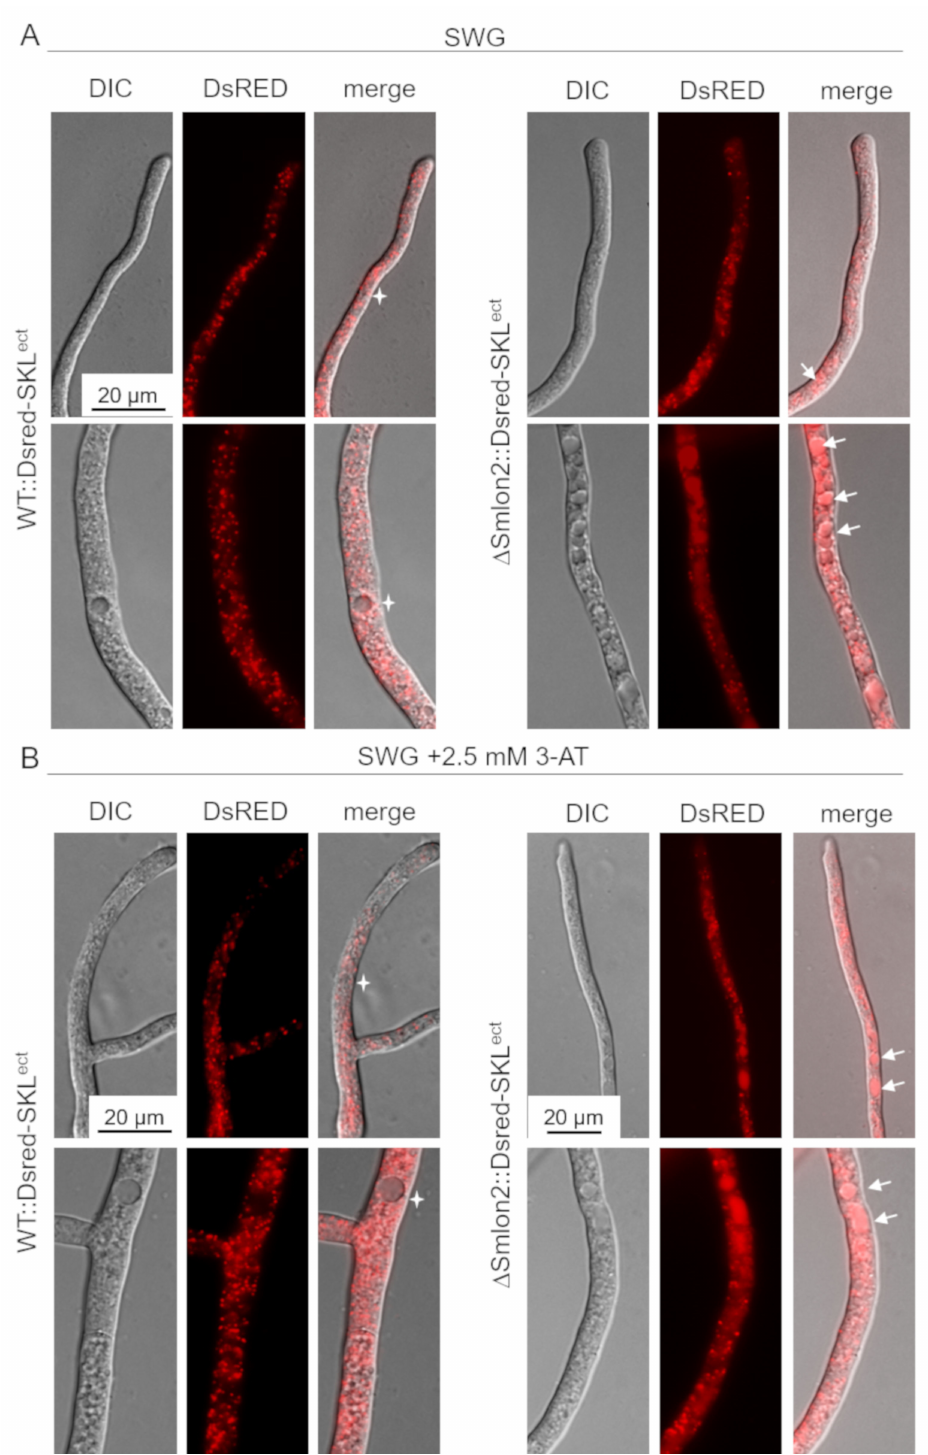
Figure 6. Localization studies of the glyoxysomal marker protein DsRED-SKL in WT and ∆ Smlon2. Fluorescence microscopy was performed with WT and deletion mutant ∆ Smlon2 expressing DsRED-SKL. Upper panel : hyphal tip; lower panel : subapical hypha. ( A ) Growth of hyphae under normal growth conditions on SWG medium. ( B ) Induction of nutrient starvation by supplementing SWG with 2.5 mM 3-AT. DIC, differential interference contrast. Vacuoles with DsRED fluorescence are indicated by arrows, vacuoles without DsRED fluorescence are marked stars. Scale bars are